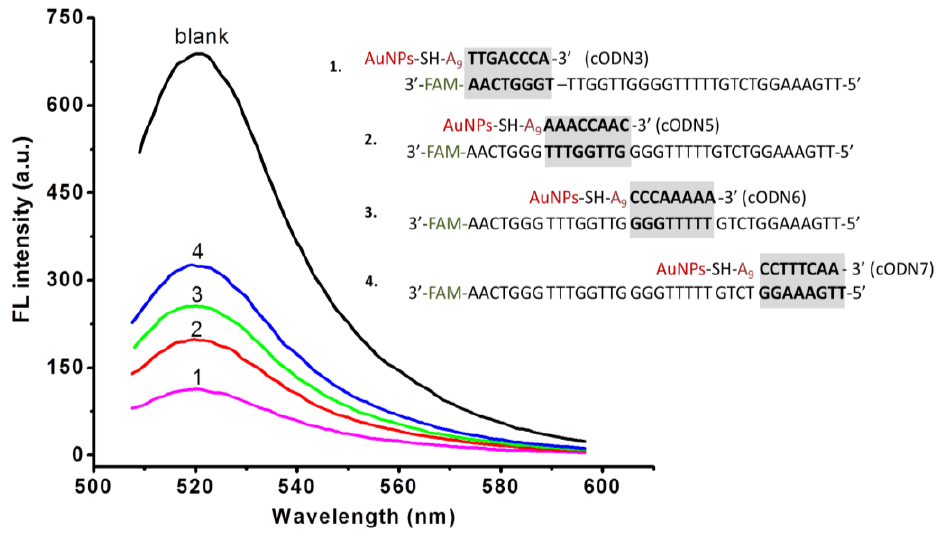
Figure 3. Effect of hybridization sites between cODN-AuNPs and FAM-Apt on the background fluorescence intensity of Apt-AuNPs. The concentration of FAM-Apt is 120 nM, and blank represents only FAM-Apt existed. Curves 1, 2, 3 and 4 represent the fluorescence of four kinds of Apt-AuNPs having different hybridization sites of 8 bp.